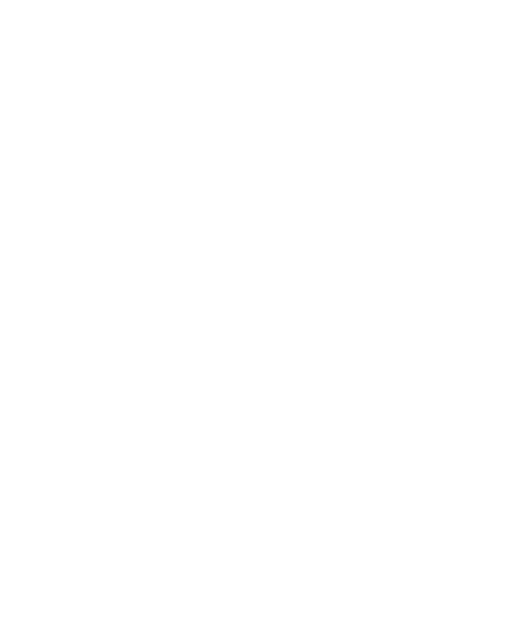
Table 2. Logistic regression model for PPCS. *At time of injury; OR odds ratio, CI confidence interval. a Extracranial soft tissue traumatic finding or cranial fracture